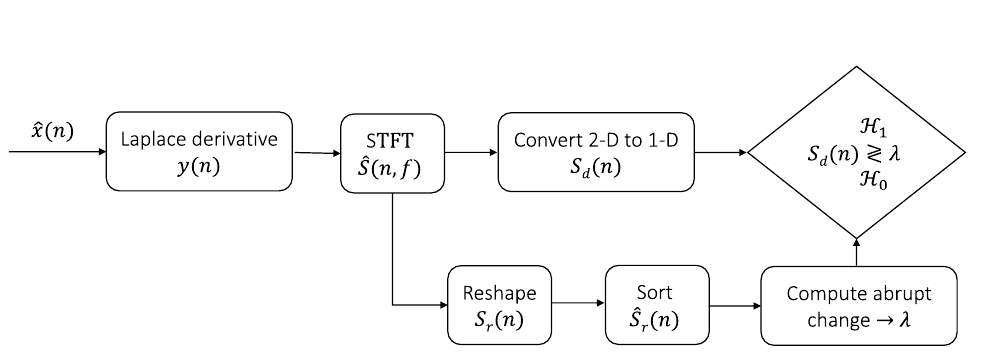
Table 2. Mean, standard deviation ( SD ), and percent of occurrence ( O ) for the peak and notch patterns established by Soldevilla et al. 15 . Adapted from Test data part of their Table IV.